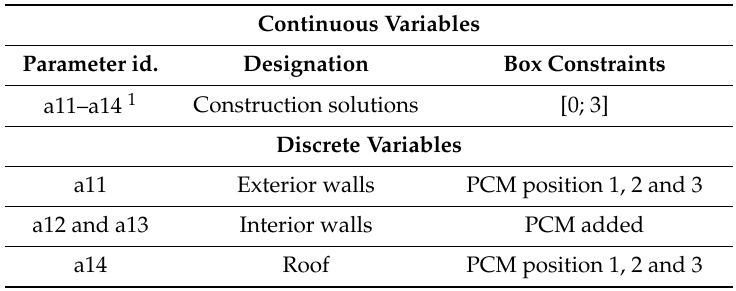
Table 4. New set of parameters and